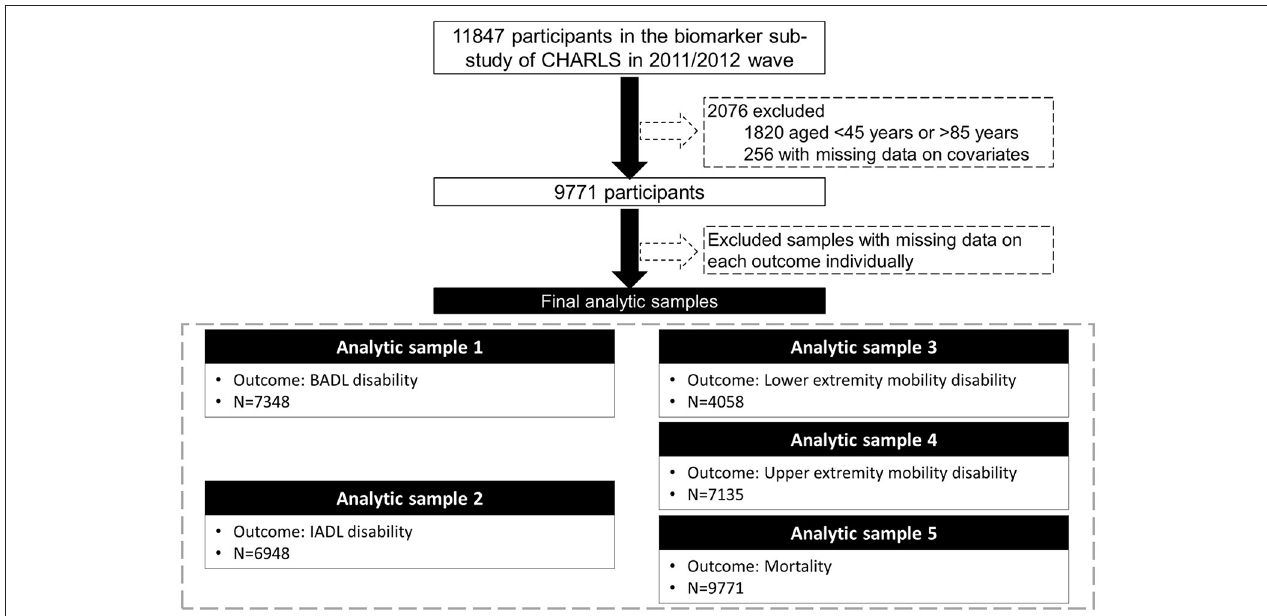
FIGURE 1 | Flow chart of the analytic sample. CHARLS, the China Health and Retirement Longitudinal Study; BADL, basic activities of daily living; IADL, instrumental activities of daily